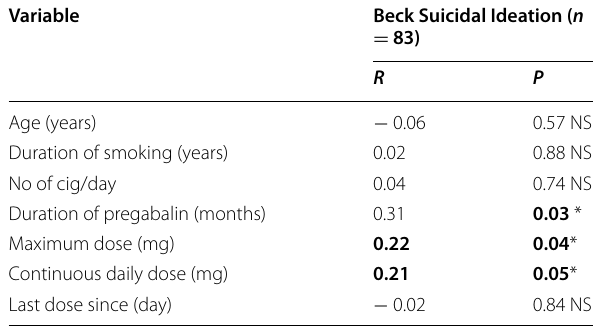
r Spearman’s correlation coefficient. NS non-significant ( P >